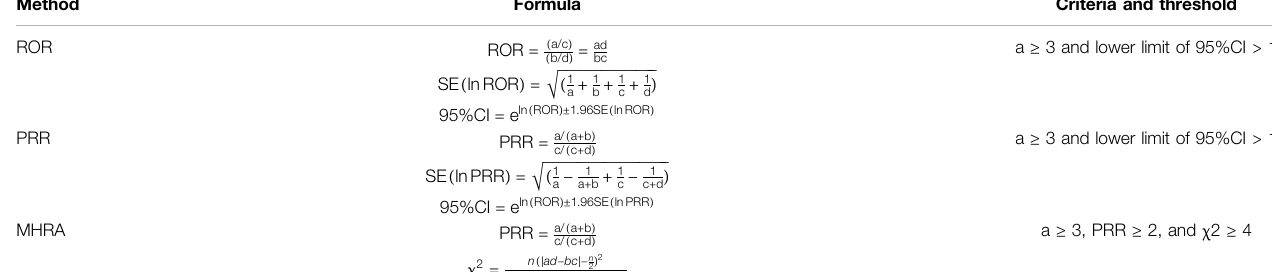
TABLE 2 | Formulas and criteria for generating signals of ROR, PRR, and MHRA. Method Formula Criteria and